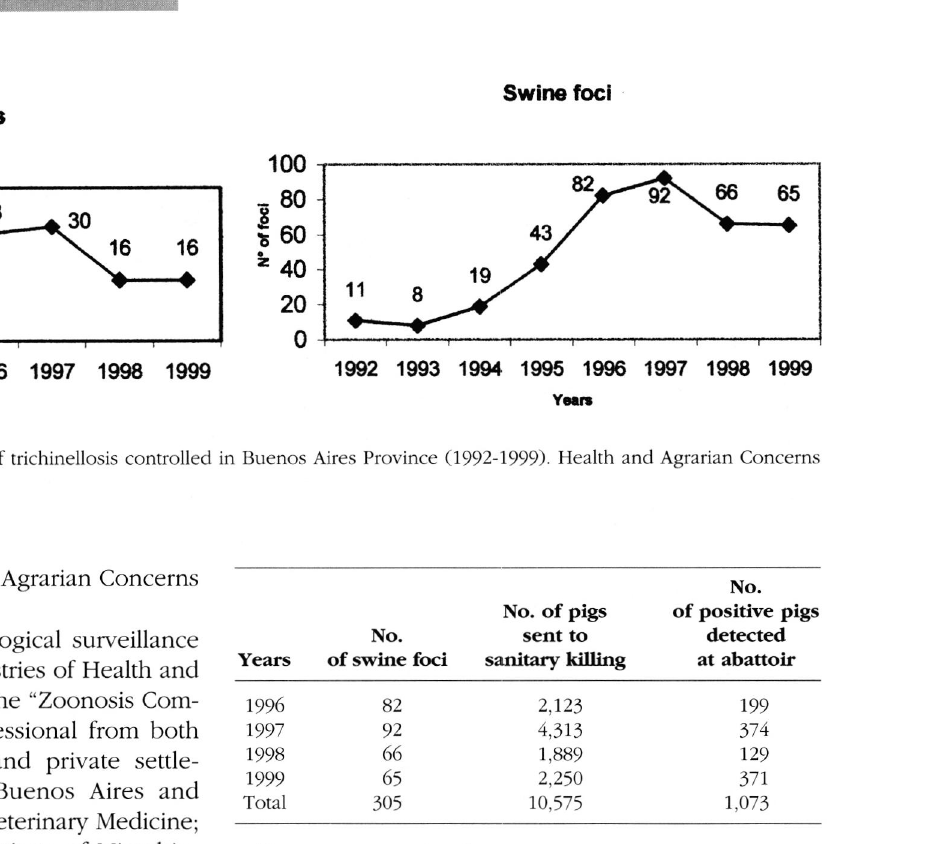
Table I. - Swine Trichinellosis in Buenos Aires Province: sanitary killing of pigs from infected farms detected by Agrarian Concerns office